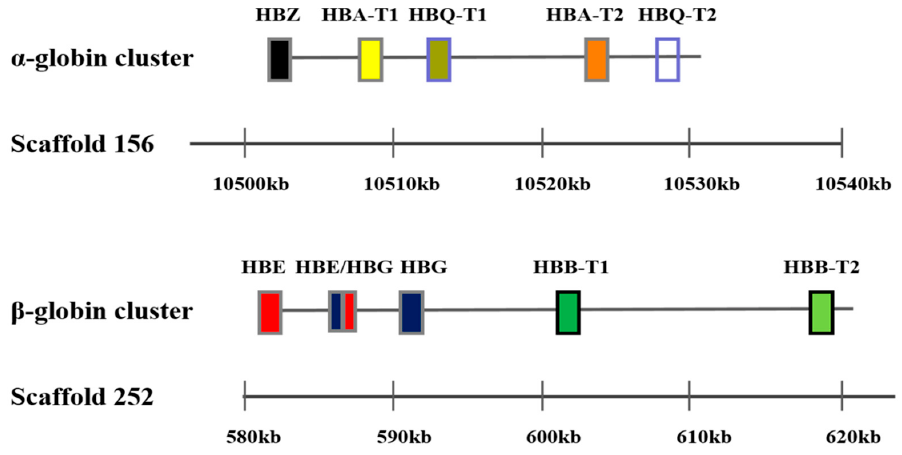
Figure 1. Genomic structure of the α and β -globin gene family in the Mandarin vole. Table 1. Lengths and accession numbers of Hb genes and differences in the number of amino acids encoded by Hb genes in the Mandarin and Brandt’s vole.